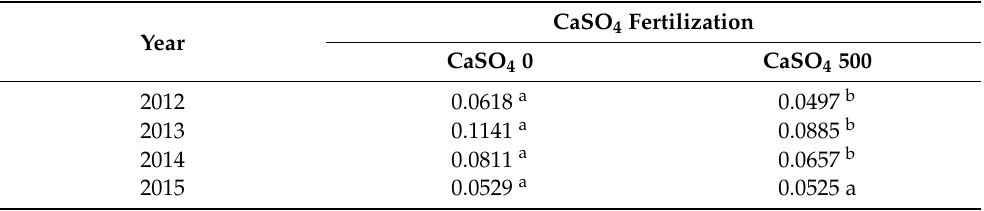
Table 7. Effect of year × CaSO 4 fertilization interaction on alkaline phosphatase activity ( µ mol pNP g − 1 DM of soil h − 1